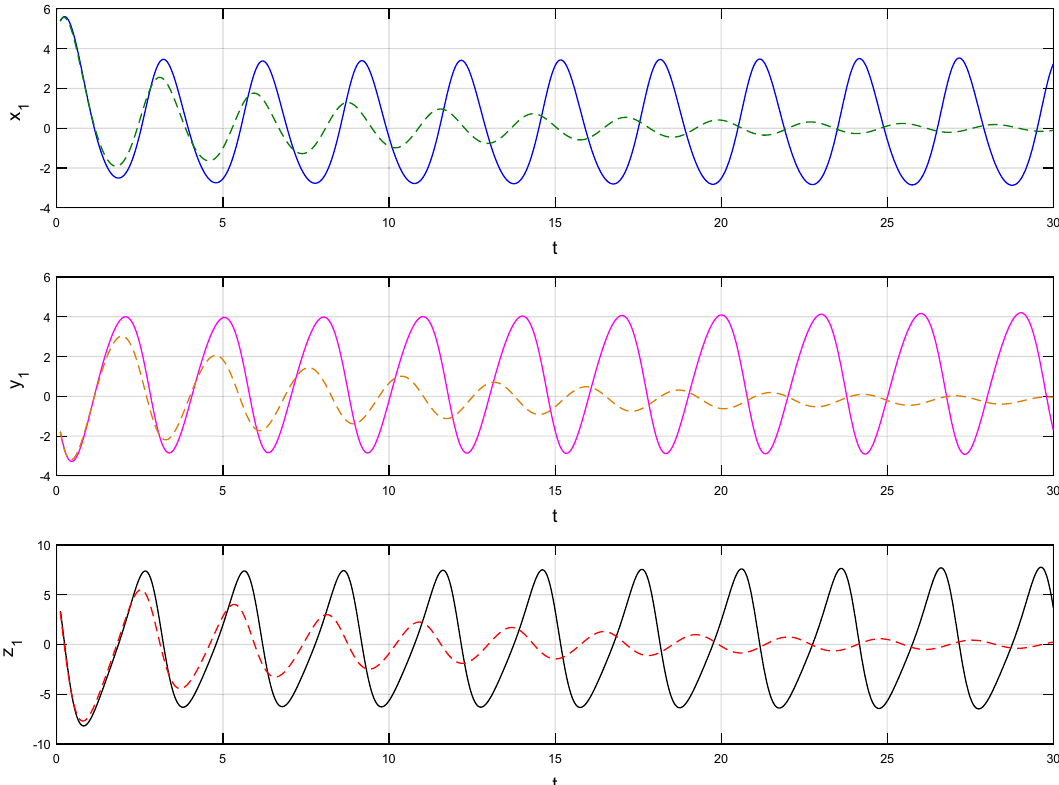
Figure 3. An analysis of the chaotic attractors for this case when α = 1 (line) and α = 0.95